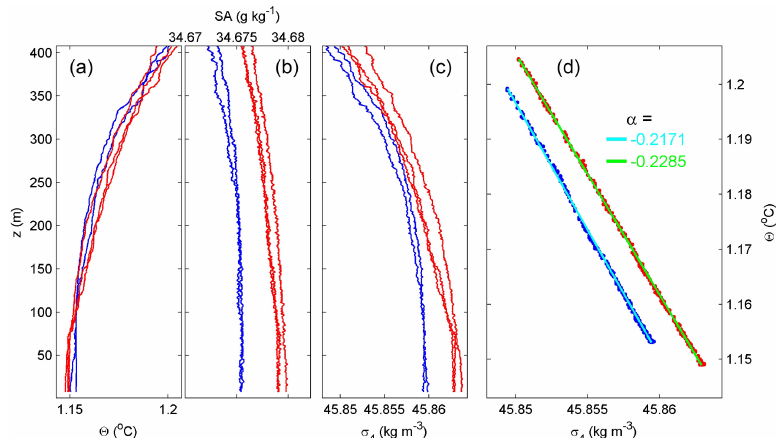
Figure B2. Lower 400m of five CTD profiles obtained near the T-sensor mooring. Red data are from around the beginning of the moored period, blue are from after recovery. (a) Conservative temperature. (b) Absolute salinity with x axis range matching the one in (a) in terms of equivalent relative contributions to density variations. The noise level is larger than for temperature. (c) Density anomaly referenced to 4000dbar. (d) Density anomaly–conservative temperature relationship ( δσ 4 = αδ(cid:50) ). The data yielding two representative slopes after linear fit are indicated (the mean of five profiles gives <α > =− 0.223 ± 0.005kgm − 3 ◦ C − 1